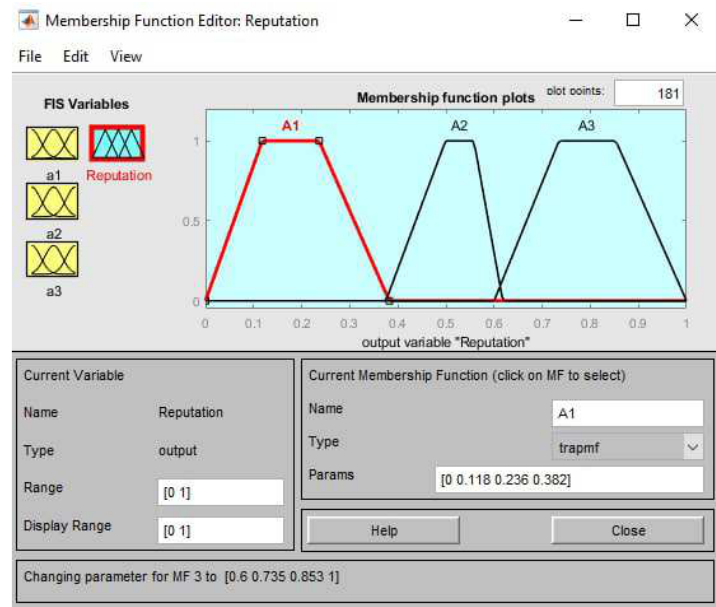
Figure 4. Obtaining the intermediate parameter company reputation (A1)